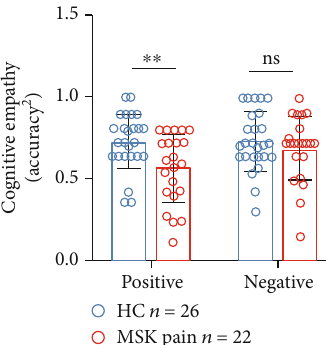
Figure 4: Comparisons of squared cognitive empathy accuracy between chronic musculoskeletal pain (MSK pain) and healthy control (HC) groups in positive/negative emotional valence conditions. In the positive condition, the squared cognitive empathy accuracy was signi fi cantly lower in the MSK pain group than the HC group, while there was no signi fi cant di ff erence in the negative condition. ns: no signi fi cant; ∗∗ P < 0 : 01 .